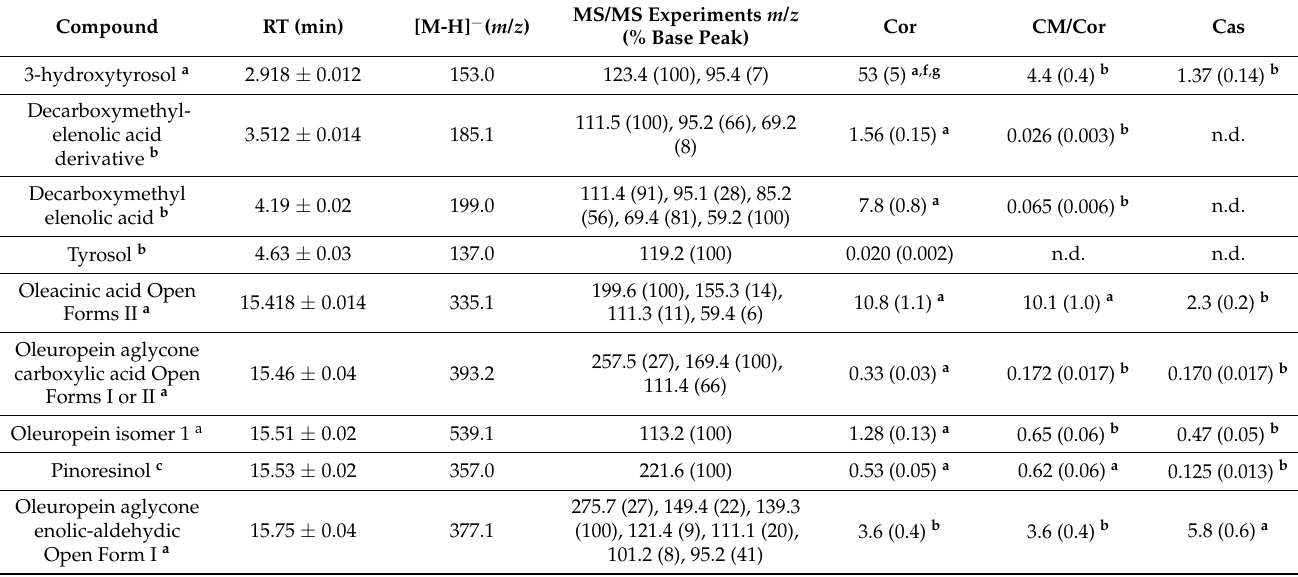
Table 1. HPLC-UV-MS/MS (ESI-) analyses of polar phenols in EVOO extracts.